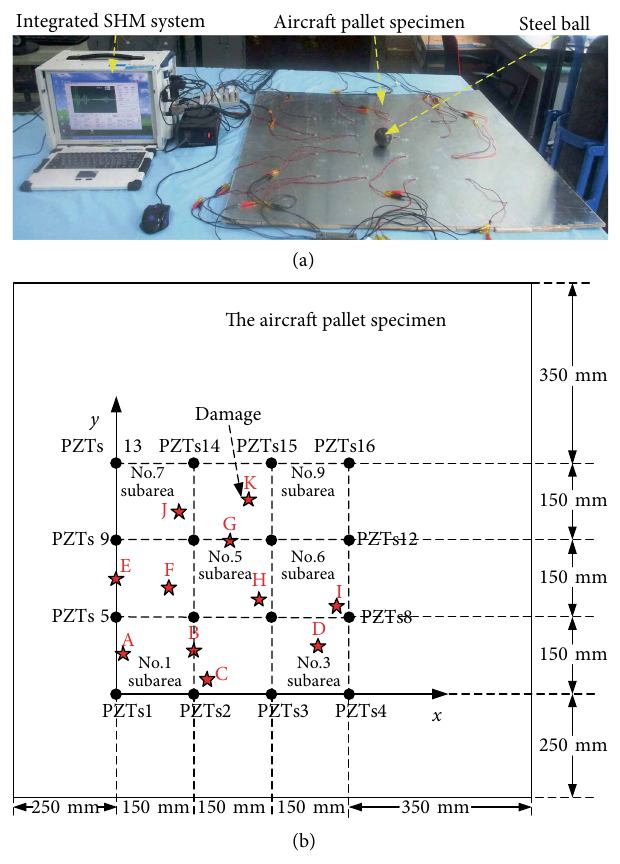
Figure 8: The experimental system for validation of the aircraft pallet damage monitoring method. (a) Experimental system; (b) piezoelectric transducer sensor placement and damage positions.